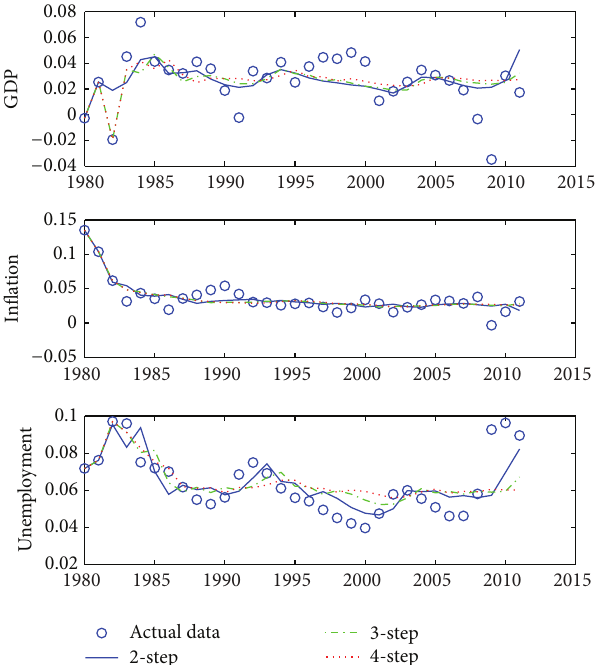
Figure 5: The actual data and in-of-sample prediction of the GDP, inflation, and unemployment with the linear model (1).